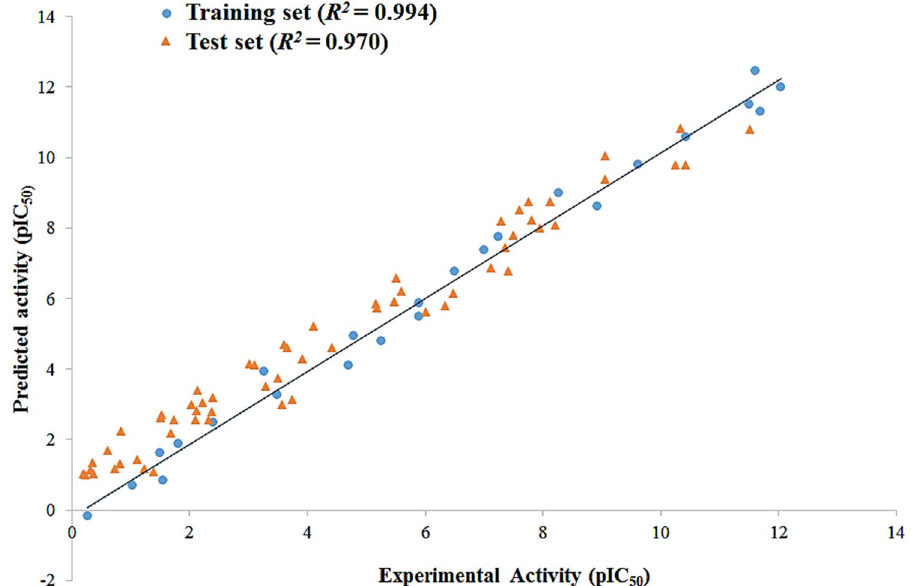
Figure 5. Correlations between the experimental activities and the predicted activities using Hypo 1 with the test set and training set compounds. The figure is drawn using Microsoft Excel 2013